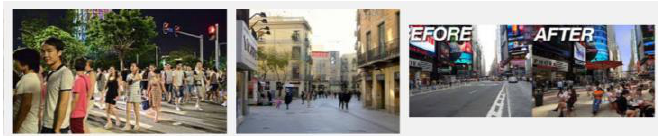
Figure 3. Examples of Part-time Pedestrian